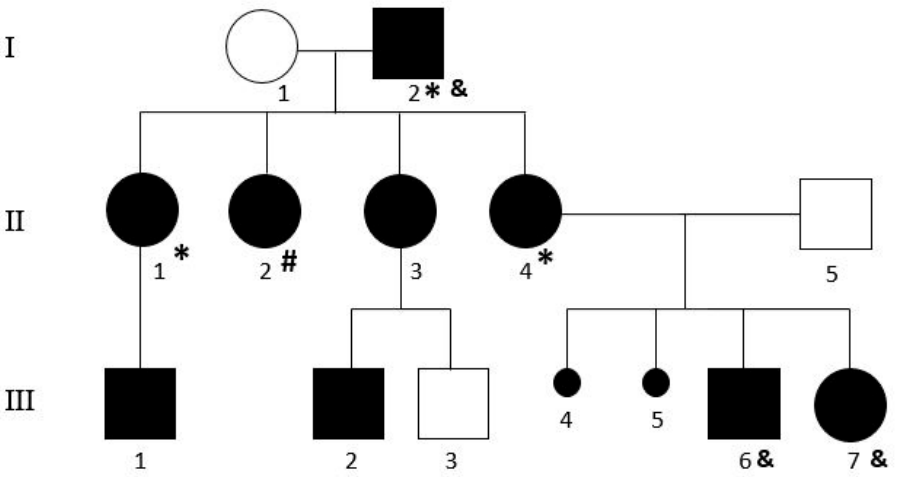
Figure 1. Pedigree of the family. “*” and “#” indicate the individuals carriers of arr[GRCH37]1q25.2(178443054_178964320)x3 and arr[GRCH37]Xp22.33(1217017_1378646)x3, respectively. “&” indicates the subjects in which the WES was performed.